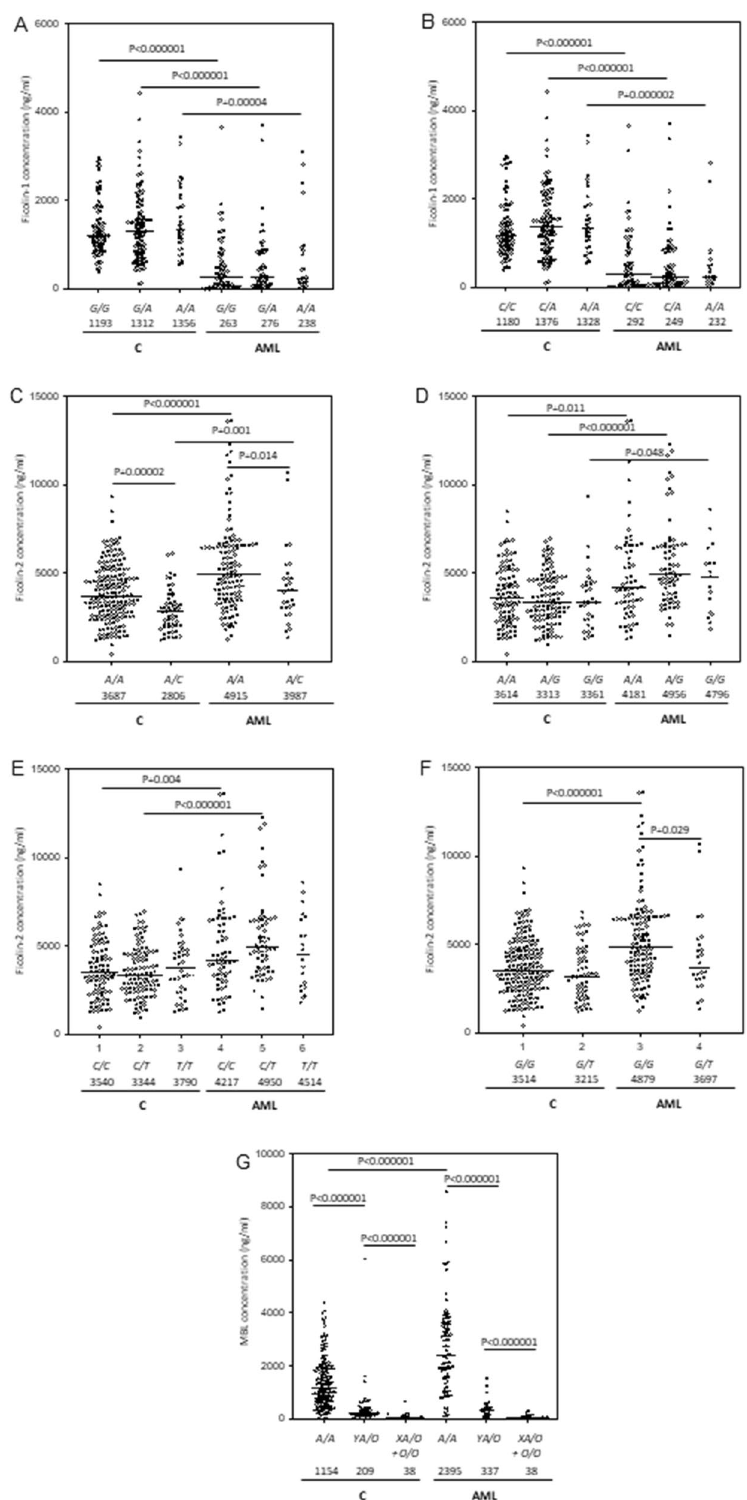
Figure 2. Serum concentrations of ficolin-1, ficolin-2 and mannose-binding lectin in patients (AML) and controls (C), depending on polymorphisms investigated. Bars represent median values (given below genotype descriptions). The medians were compared using the Mann–Whitney U -test (p given when significant differences were observed). ( A ) ficolin-1 levels and − 542 G > A polymorphism; ( B ) ficolin-1 levels and − 144 C > A polymorphism; ( C ) ficolin-2 levels and − 64 A > C polymorphism; ( D ) ficolin-2 levels and − 4 A > G polymorphism; ( E ) ficolin-2 levels and + 6,359 C > T polymorphism; ( F ) ficolin-2 levels + 6,424 G > T polymorphism. ( G ) MBL levels and common promoter ( Y/X ) and exon 1 ( A/O )